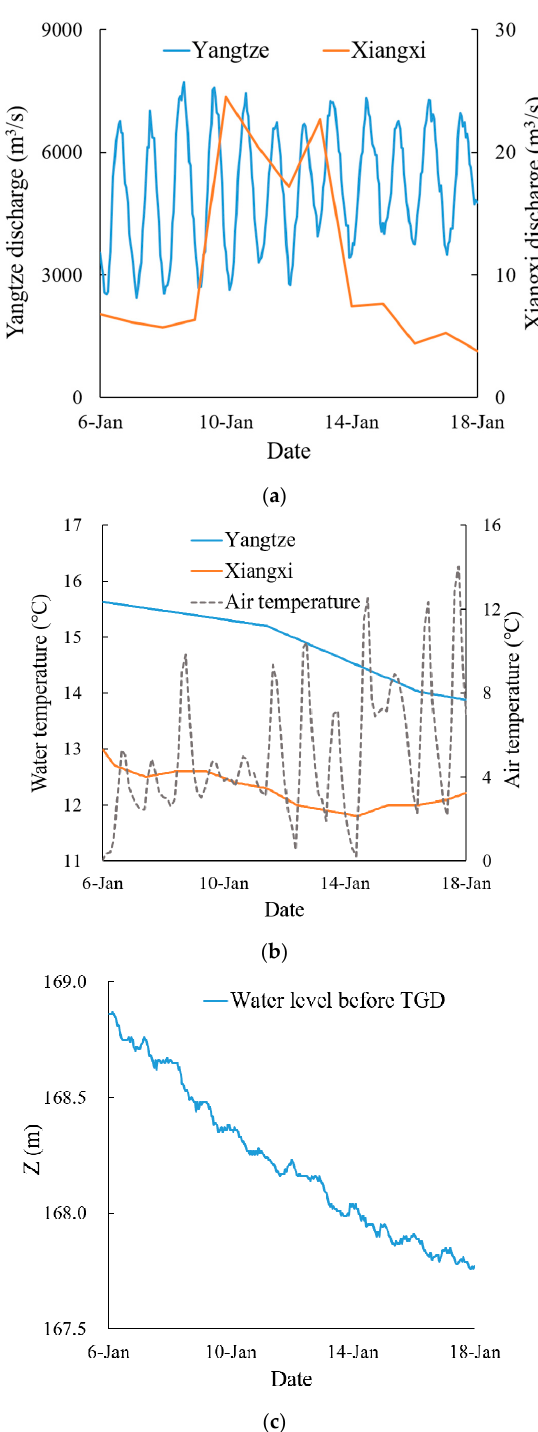
Figure 8. Boundary conditions of the TELEMAC-3D model: ( a ) flow discharge hydrographs of the Yangtze River and the Xiangxi River, ( b ) air temperature and inflow water temperature variation of the Yangtze River and the Xiangxi River, and ( c ) water elevation variation hydrograph for the outlet of the